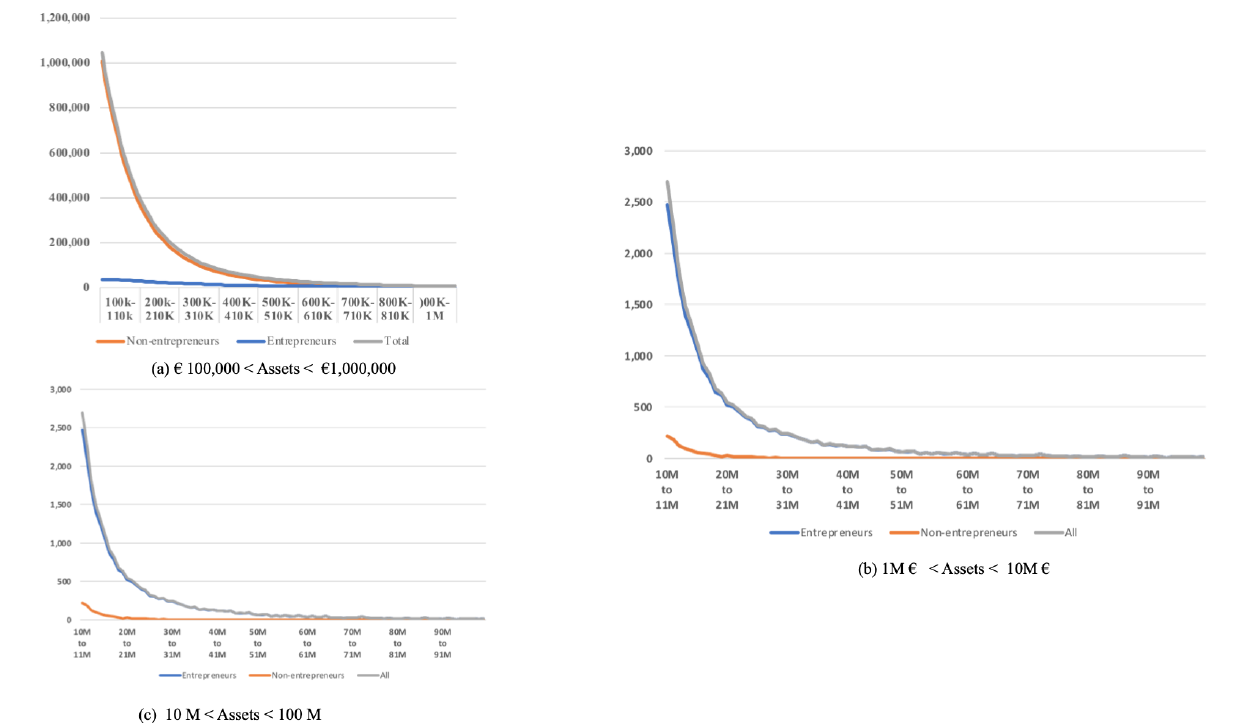
Figure 5. Assets distribution.